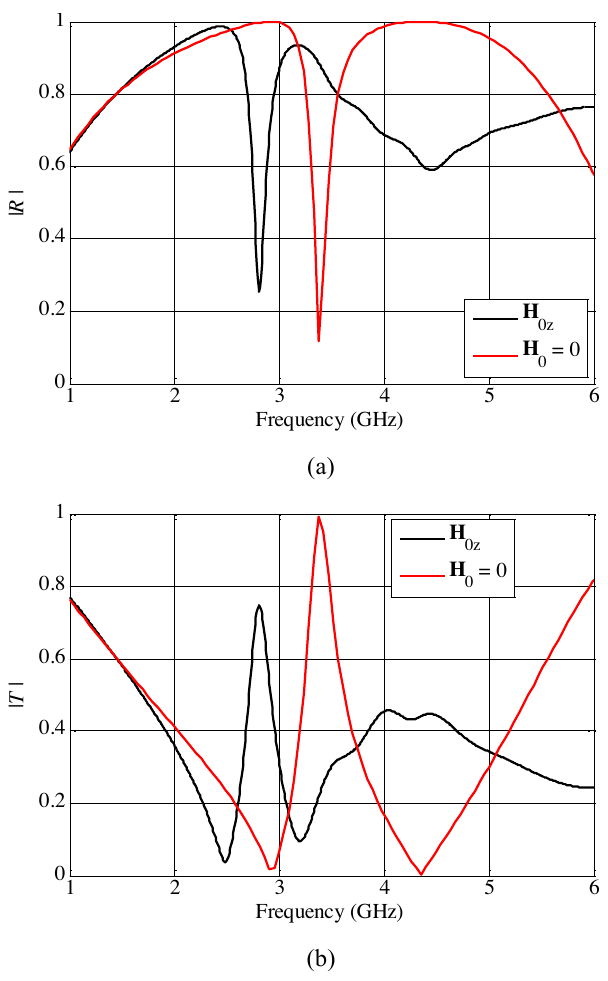
Figure 3. Reflection (a) and transmission (b) spectra of the array placed on a ferrite substrate magnetized in z - direction and for a non-magnetized one; ω